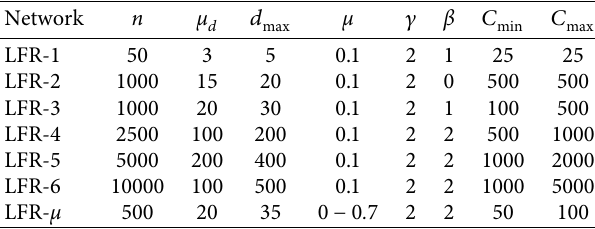
Table 3: Parameters for generating benchmark LFR networks; n indicates the number of nodes in the network, μ d is the average node degree, the maximum node degree is represented by d , μ max shows the value of the mixing parameter, c denotes the exponent of the power law distribution for degree distribution, and β represents the exponent of the power law distribution for community sizes, the minimum community size and the maximum community size are denoted by C and C , respectively. LFR- μ is used for the min max purpose of showing the efect of changing the mixing parameter ( μ )